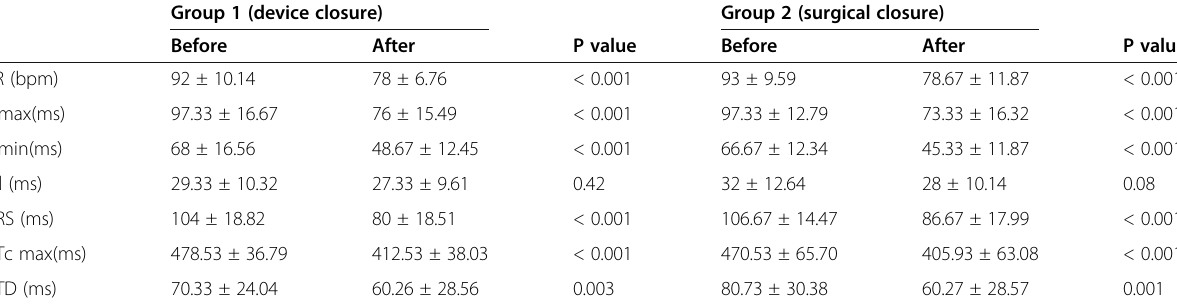
Table 2 ECG parameters before and after ASD closure in device and surgical group Group 1 (device